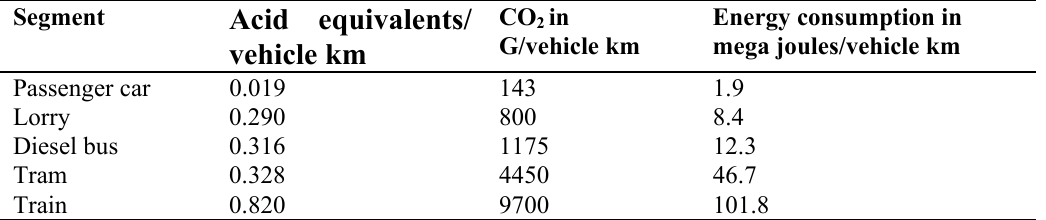
Table 3. Emission factors for acidification, greenhouse effect, and energy consumption